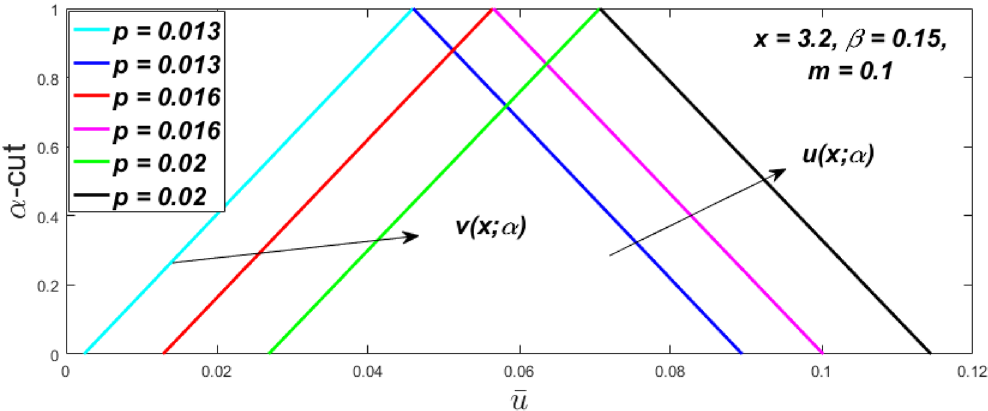
Figure 43. Triangular MF of fuzzy velocity for the impact of p.